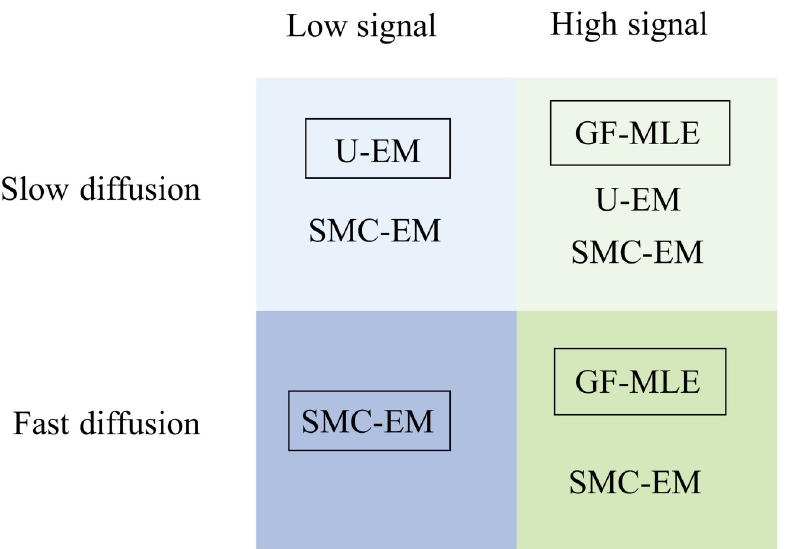
Fig 17. Qualitative guidance for choice of SPT localization and parameter estimation algorithm. Shown are the algorithms that produce similar results in each of the domain with the method. The boxed algorithm in each quadrant has the lowest computational